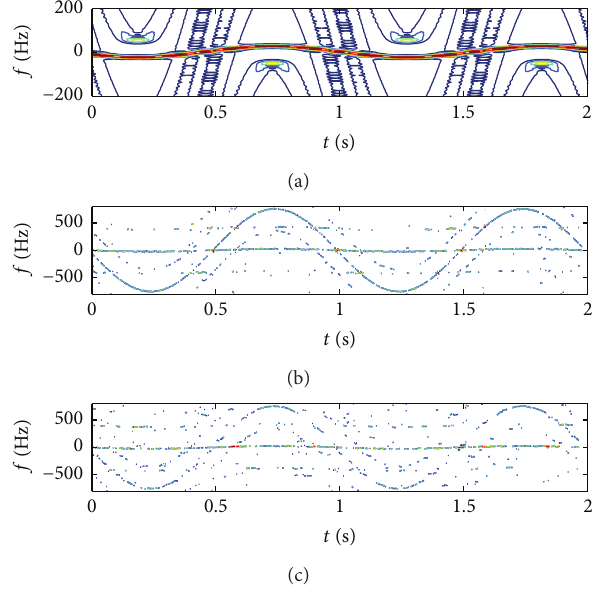
Figure 5: Micro-Doppler time-frequency spectrum: ambigu- ous time-frequency spectrum via STFT (a); unambiguous time- frequency spectrum of adding-perturbation fixed-PRF via CS (b); unambiguous time-frequency spectrum of adding-perturbation sparse-PRF via CS